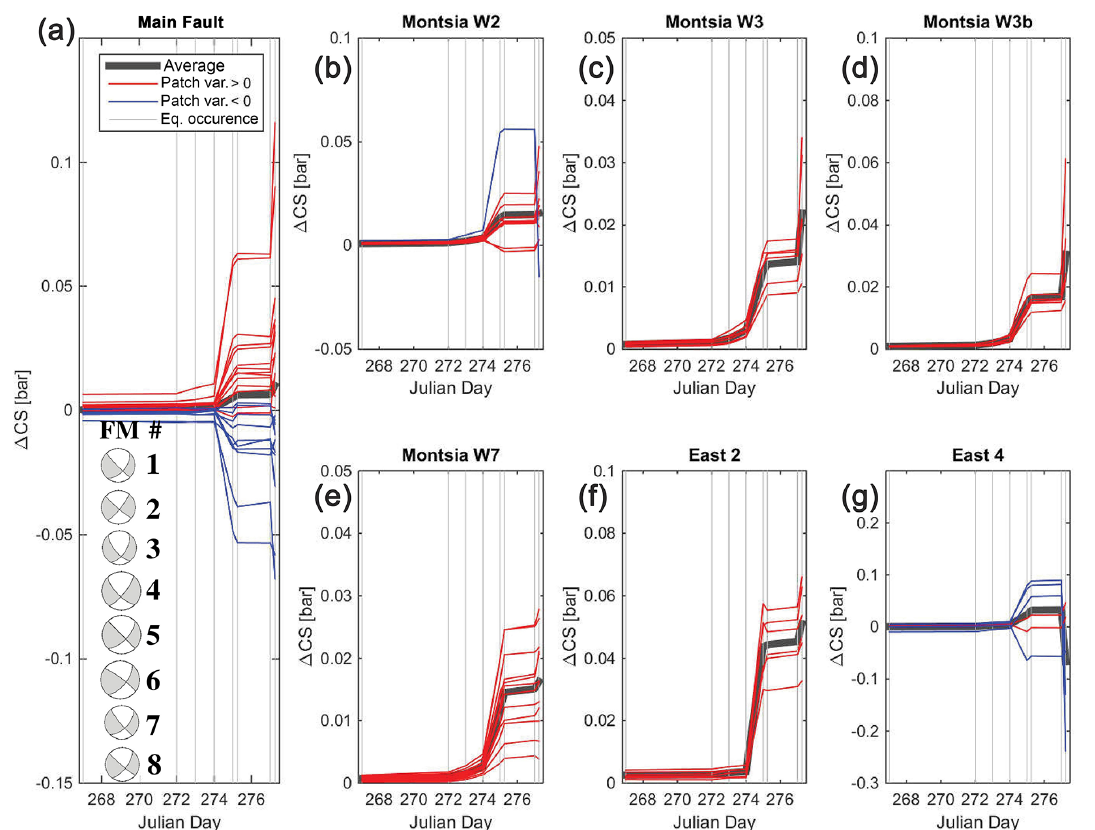
Figure D2. Time series of (cid:49) CS computed onto each patch of the mapped faults. The discontinuous vertical lines indicate the occurrence of an earthquake (note that day 267 has one occurrence, and days 275 and 277 have two) with the focal mechanism indicated in the left panel (a) . Red lines indicate that the final (cid:49) CS value on a patch is positive, while blue is used for those that are negative (inhibited) at the end. The gray weighted line on each panel represents the mean evolution as reported in Table D1. Vertical scale changes among